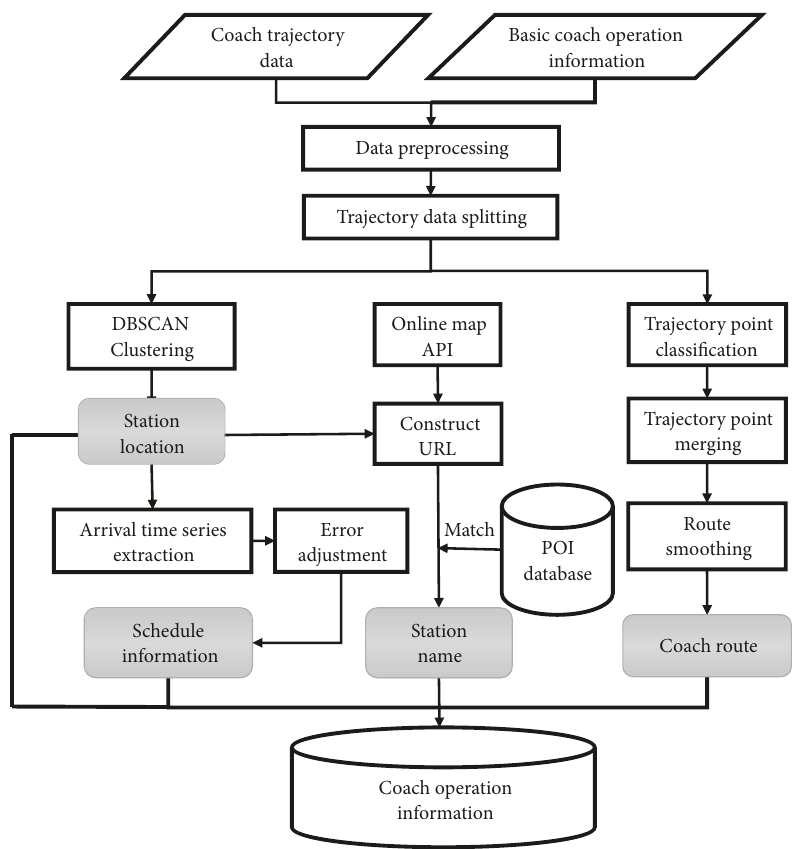
Figure 1: Overall workflow of extracting coach operation information based on trajectory